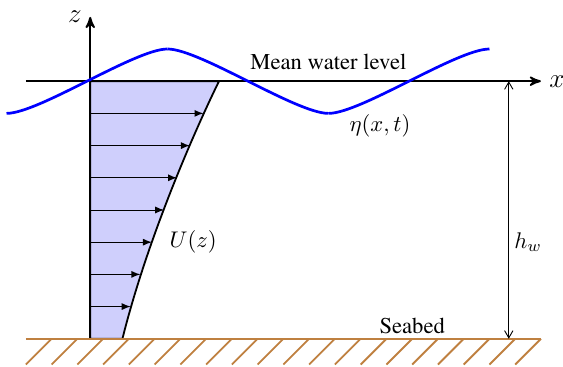
Figure 3. Coordinate system for wave–current interaction